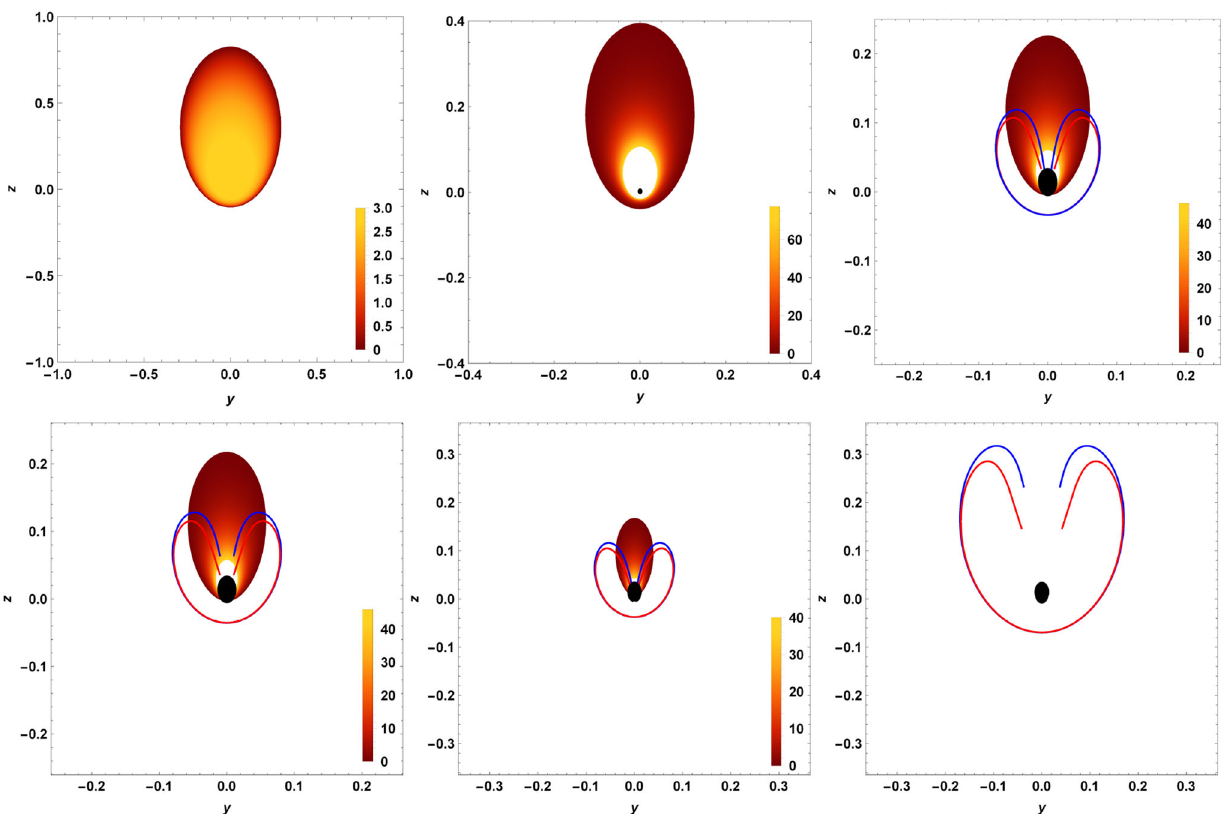
Fig. 1 Cross-section along fixed φ = π/ 2 of the evolution of the forms at t = 2 / 3. Evolution of event horizon (solid black ellipsoid) collapsing aspherical dust cloud (higher matter density corresponds depends on θ . The event horizon touches the boundary of the collaps- to darker shade, and lesser matter density corresponds to brighter ing cloud first at θ = π at t = 0 . 868. The aspherical wavefronts of shade), and the global causal structure of the singularity thus formed, is singular null geodesics (red and blue colored) escape the singularity, depicted.Toppanelcorrespondstotime t = 0, t = 0 . 678and t = 0 . 868. thereby making it globally visible. However, part of these outgoing Bottem panel corresponds to time t = 0 . 876, t = 0 . 92, and 1 . 004. wavefronts which lies in the neighbourhood of θ = 0 gets trapped by The figures are symmetric with change in φ . Here, A = r 3 − 20 r 6 , the trapped surfaces and falls back to the singularity, hence making it (cid:8) (cid:9) θ + exp ( − r ) only directionally globally naked in the neighbourhood around θ = π f = − 10 − 3 r 2 and Q = exp ( r ) tan 2 . The singularity 2 4